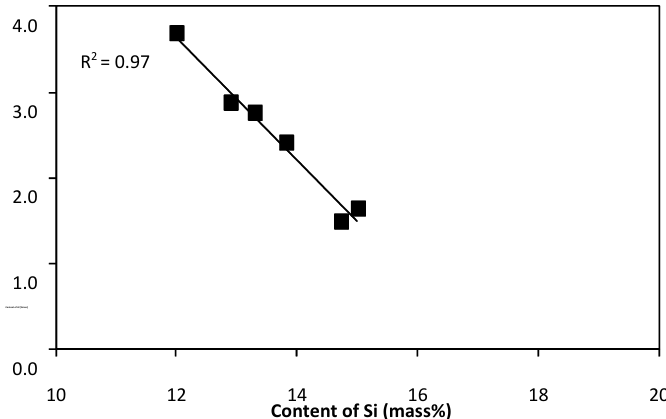
Figure 6. Di ff erentiation of Si and Al content in Figure 6. Differentiation of Si and Al content in kirschsteinite.